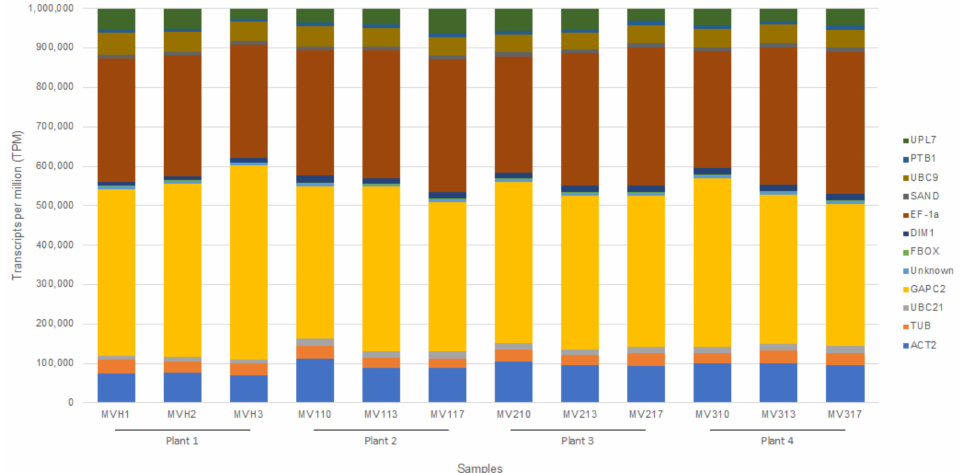
Figure 2. Stacked column chart displaying the transcripts per million (TPM) values for each ref- erence gene analyzed. The ratios of the TPM count of each gene relative to the TPM count of the other genes are displayed for each sample subjected to the CTAB/Illumina HTS protocol (SAND: SAND family protein; DIM1: DIM1 homolog/YLS8; Unknown protein: Citrus sinensis carno- sine N-methyltransferase-like transcript; FBOX: F-box family protein; UPL7: Ubiquitin-protein ligase 7; UBC21: Ubiquitin-conjugating enzyme 21; PTB1: Polypyrimidine tract-binding protein 1; GAPC2: Glyceraldehyde-3-phosphate dehydrogenase C2; UBC9: Ubiquitin conjugating enzyme 9; ACT2: Actin-2; EF-1a: Elongation factor 1-alpha; TUB: beta-Tubulin). MVH1, MVH2, and MVH3 rep- resent RNA extraction technical replicates from healthy plant 1 ( C. sinensis cv. ‘Madam Vinous’, sweet orange), MV110, MV113, and MV117 represent RNA extraction technical replicates from infected plant 2 ( C. sinensis cv. ‘Madam Vinous’, sweet orange), MV210, MV213, and MV217 represent RNA extraction technical replicates from infected plant 3 ( C. sinensis cv. ‘Madam Vinous’, sweet orange), and MV310, MV313, and MV317 represent RNA extraction technical replicates from infected plant 4 ( C. sinensis cv. ‘Madam Vinous’, sweet